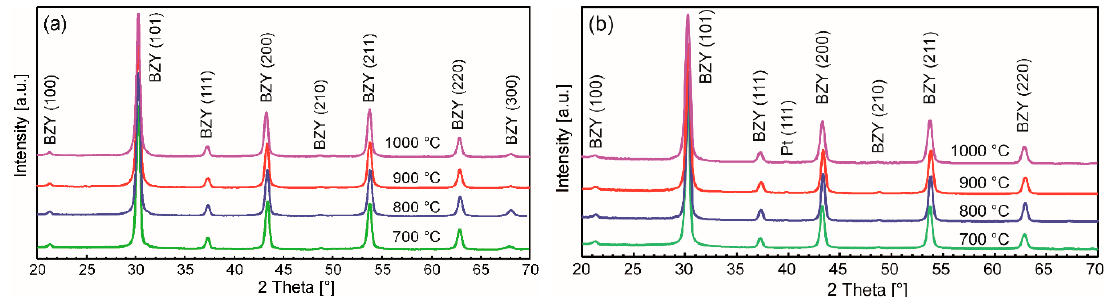
Figure 6. XRDs of BZY10 films derived from the two precursor systems. ( a ) con -BZY and ( b ) µE -BZY annealed at different temperatures recorded in grazing incidence. Both films show already the expected reflections for crystalline BZY at 700 °C with cubic indexation. Temperatures and reflex indexes are indicated in the diagrams.